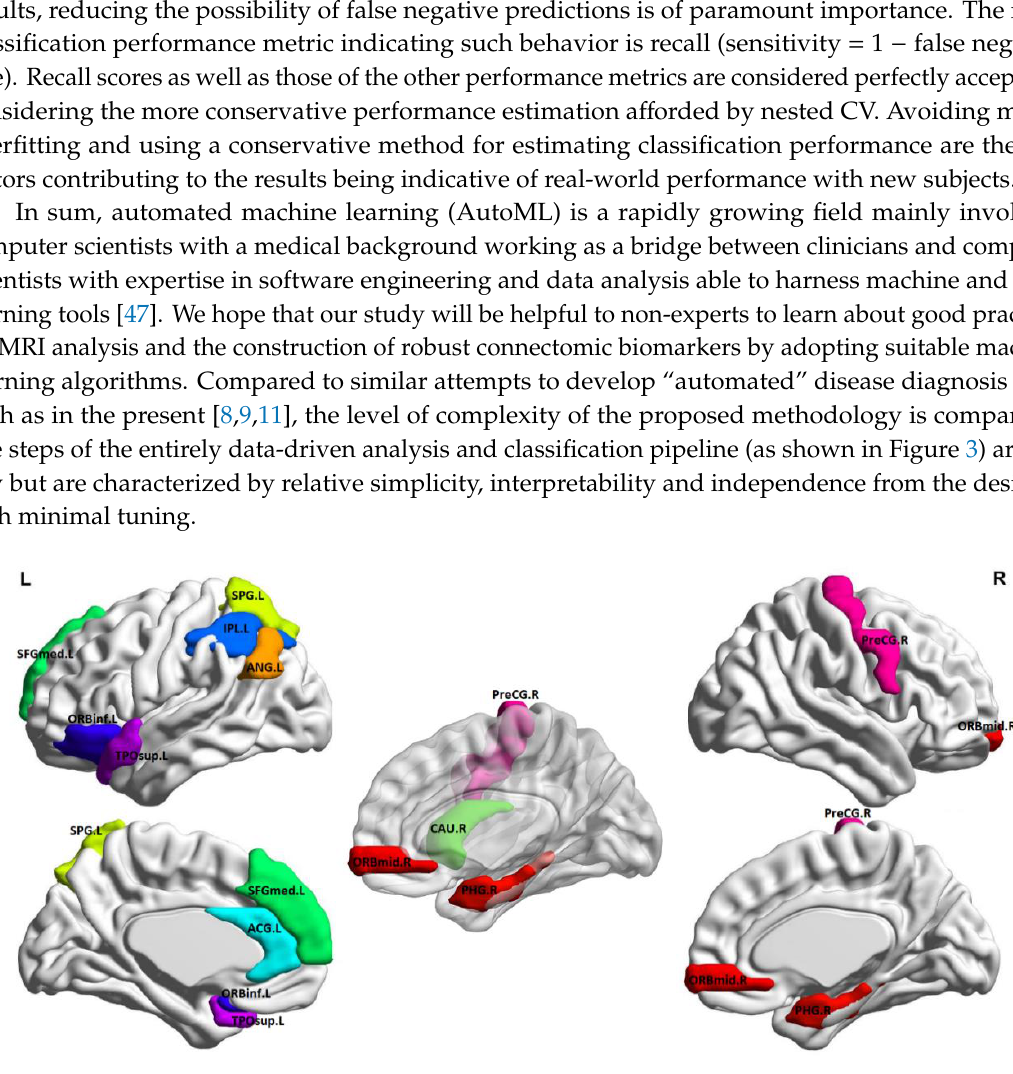
Figure 3. Outline of the 11 ROIs as specified in the automated anatomical labeling atlas (AAL) map, which provided the 12 graph metrics in the best-performing classification model discriminating between NPSLE patients and healthy controls. ROI abbreviations are explained in Table